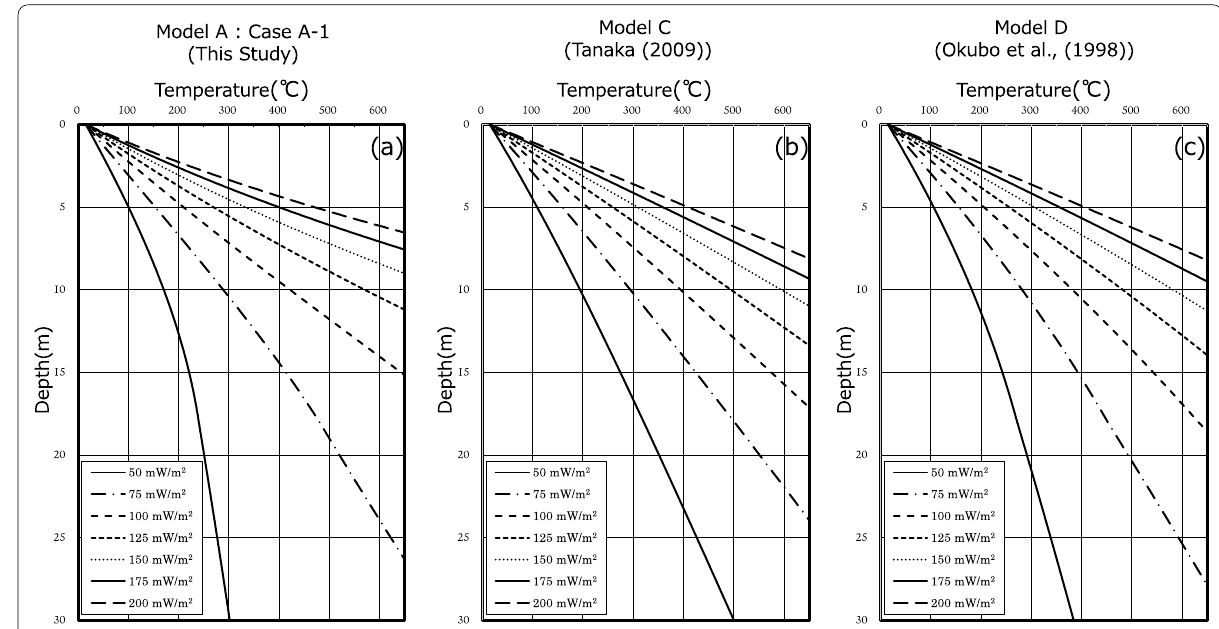
Fig. 10 Example of underground temperature calculation (1). The examples of calculations for seven cases with heat flow ranging from 50 to 200 mW m − 2 in 25 mW m − 2 increments. a Example calculation in Model A (Case A-1). b Example calculation in Model C. c Example calculation in